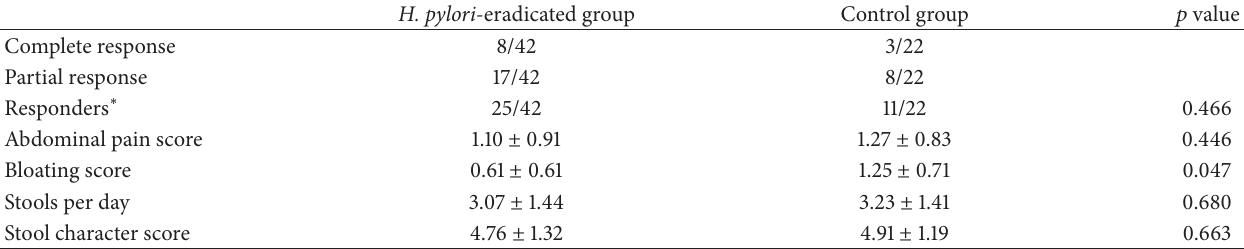
Table 4: Main study outcomes in the H. pylori -eradicated group and the control group in patients of long-term